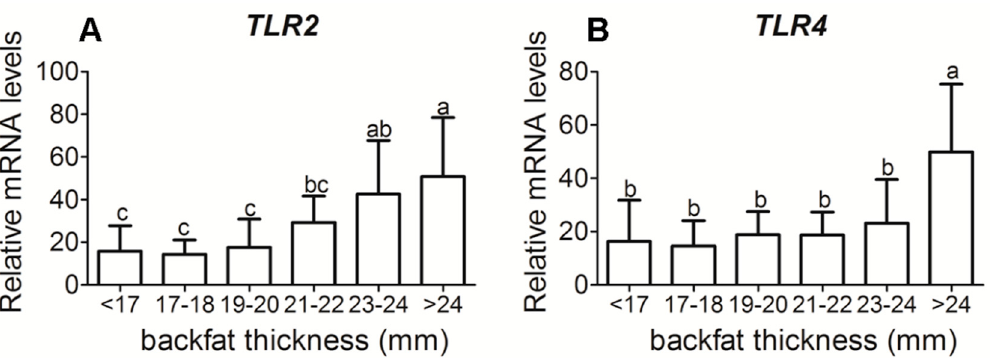
Figure 2. Toll-like receptor 2 and 4 mRNA expressions in placenta tissue of different backfat thickness sows. ( A ) Placental reactive Toll-like receptor (TLR) 2 mRNA level in different backfat thickness sows; ( B ) Placental reactive TLR4 mRNA level in different backfat thickness sows. Each group had 10–12 sows, 4–5 placenta samples were analyzed per sow, mean ± SEM. Different letter showed significant difference ( p < 0.05).